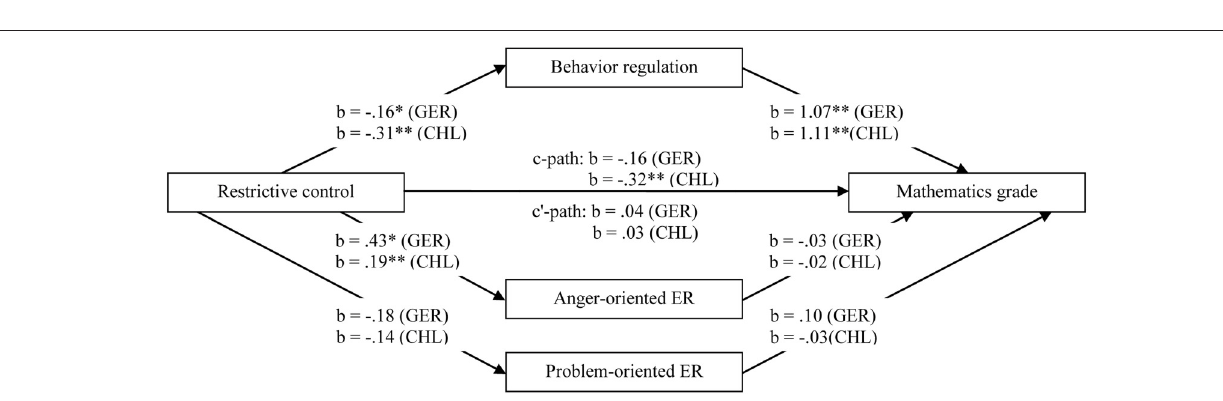
FIGURE 2 | Multiple mediation test of the relation between maternal restrictive control and mathematics grade mediated by behavior regulation, anger- and problem-oriented emotion regulation. Models were tested separately for the German and the Chilean samples. N (Germany)=76; N (Chile)=167; b=unstandardized regression coefficient, controlled for intelligence, age, and gender; GER=German sample; CHL=Chilean sample; ER= emotion regulation; * p < 0.05; ** p <